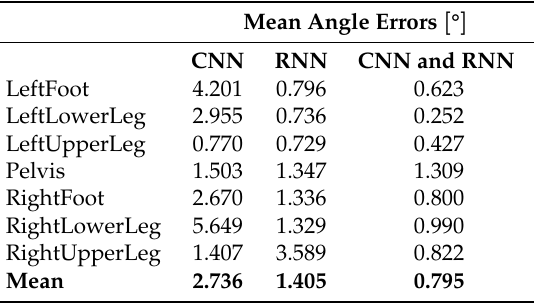
Table A9. Results of the architecture cross validation for the I2S alignment problem based on dataset A : mean angle errors over all axes and windows for each